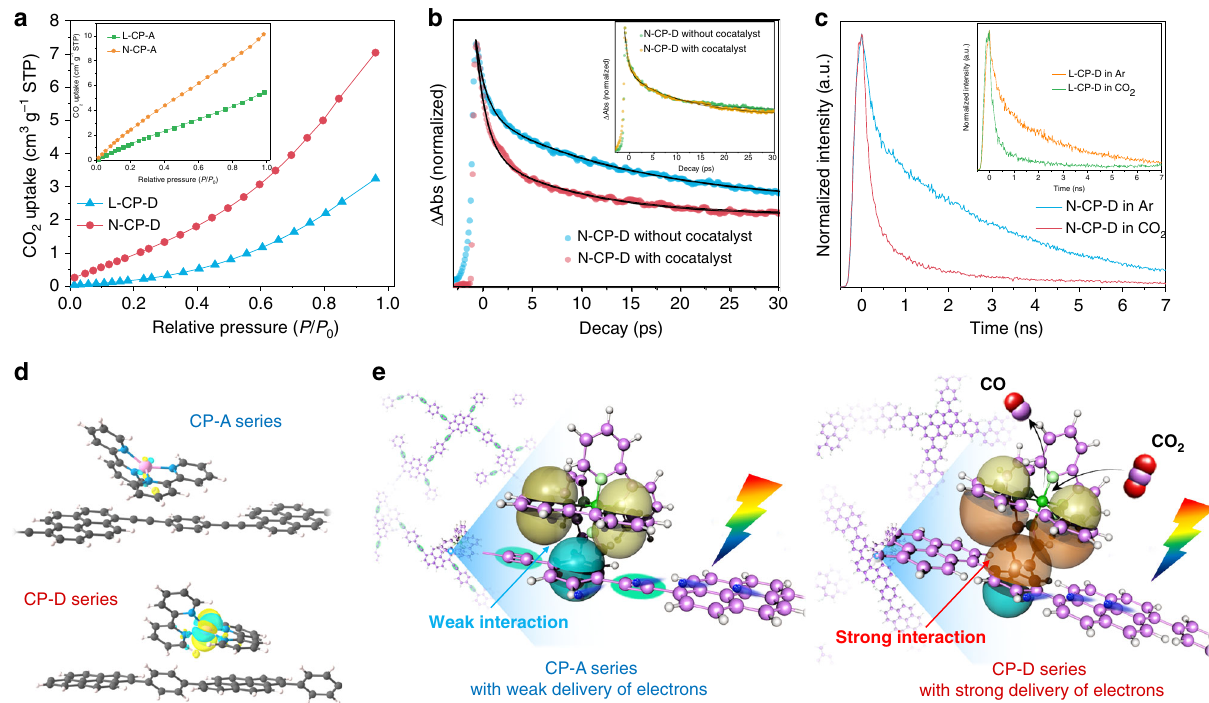
Fig. 4 Electron delivery from CPs to cocatalyst for CO2 photoreduction. a CO 2 adsorption capacities of the CP-D series and CP-A series (inset) at 273.15 K. b Kinetics of electrons in transient absorption over N-CP-D with or without cocatalyst under a probe wavelength of 2200 nm, inset: Kinetics of electrons in transient absorption over N-CP-A with or without cocatalyst under a probe wavelength of 2500 nm. c Time-resolved photoluminescence decay of L-CP-D and N-CP-D (inset) under a CO 2 or argon atmosphere. d Charge density difference of CPs in present and absent of Co (II) bipyridine complexes with the isosurfaces value of 0.001 e/Å 3 . yellow and cyan represent charge accumulation and charge depletion, respectively. The pink, indigo, dark gray and white pink balls represent Co, N, C and H atoms, respectively. e Proposed process of electron transfer over the CP-A series and CP-D series for the CO 2 photoreduction